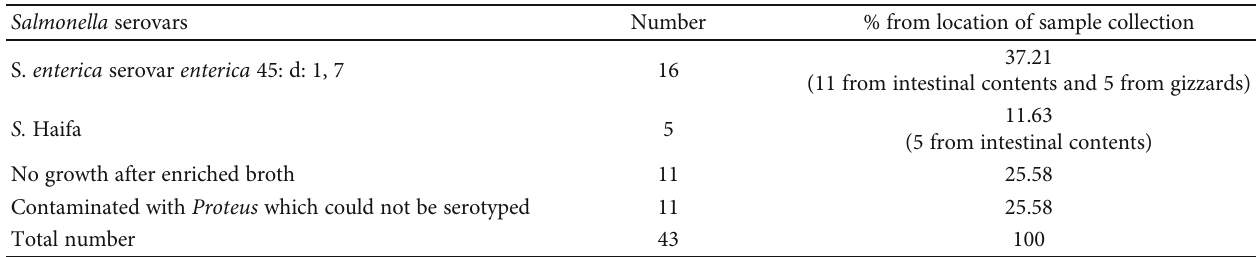
Table 6: Occurrence of Salmonella serotypes from intestinal contents and ready-to-eat chicken gizzards from the Ilorin metropolis. Salmonella